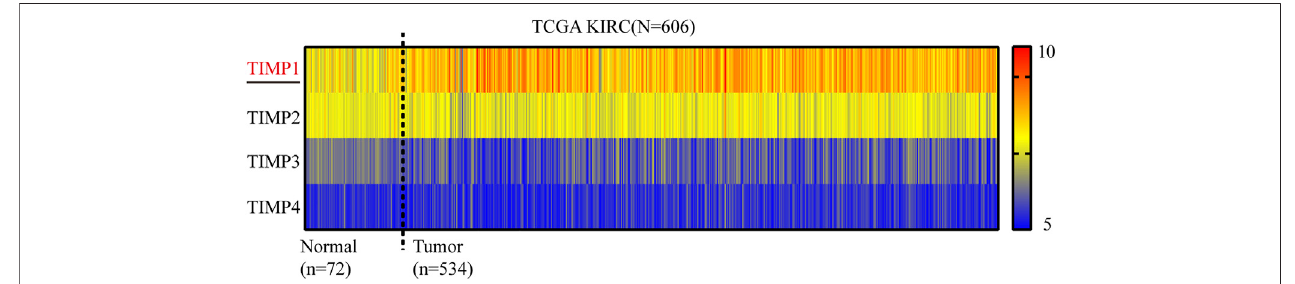
FIGURE 2 | TIMP1 was upregulated in RCC. The mRNA expression level and clinical parameters were downloaded from TCGA_KIRC. (A) mRNA levels of TIMP family proteins in RCC tissues and paired normal tissues. (B) TIMP1 was upregulated in three renal statistics downloaded from the Oncomine database, including Beroukhim,Jones,andYusenkorenalstatistics.TIMP,Tissueinhibitormatrixmetalloproteinase;TIMP1,Tissueinhibitormatrixmetalloproteinase1;RCC,clearcellrenal cell carcinoma, TCGA, The Cancer Genome Atlas; KIRC, kidney renal clear cell carcinoma.